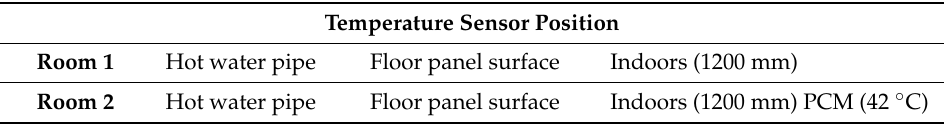
Table 6. Temperature sensor position for each